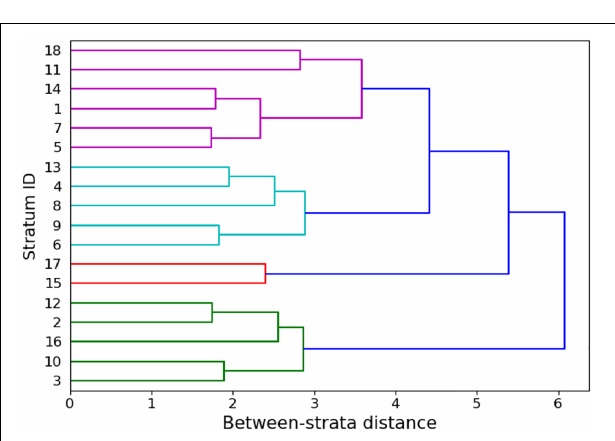
FIGURE 3 | Relative importance of regional input variables (see Supplementary Table 1 ) on mapped (A) live coral cover and (B) fine-scale rugosity.